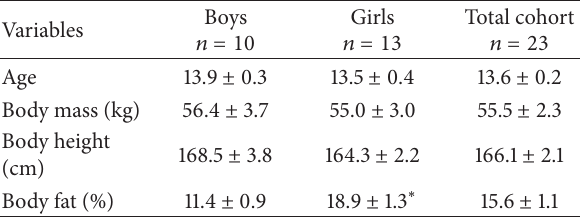
Table 1: Subjects’ physical characteristics (mean ± SE).